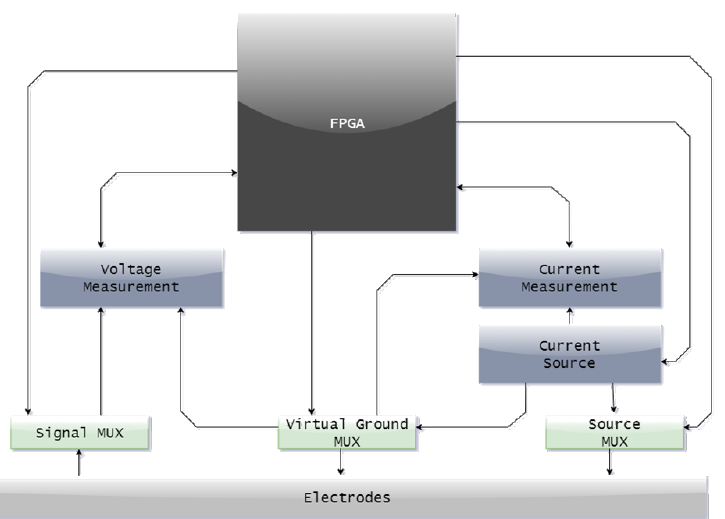
Figure 3. The block diagram of a solution containing a field-programmable gate array